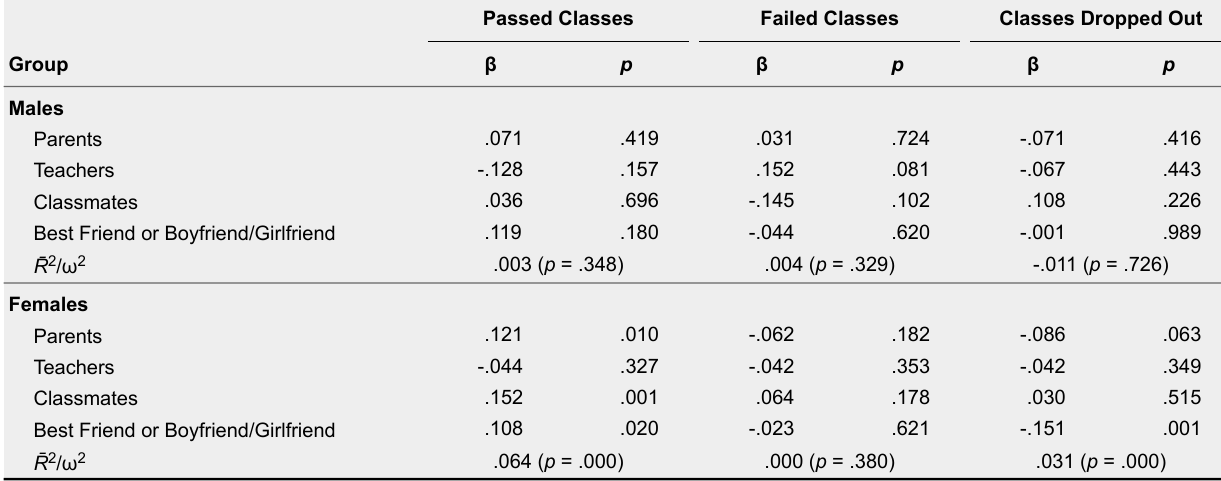
Multiple Regressions on Academic